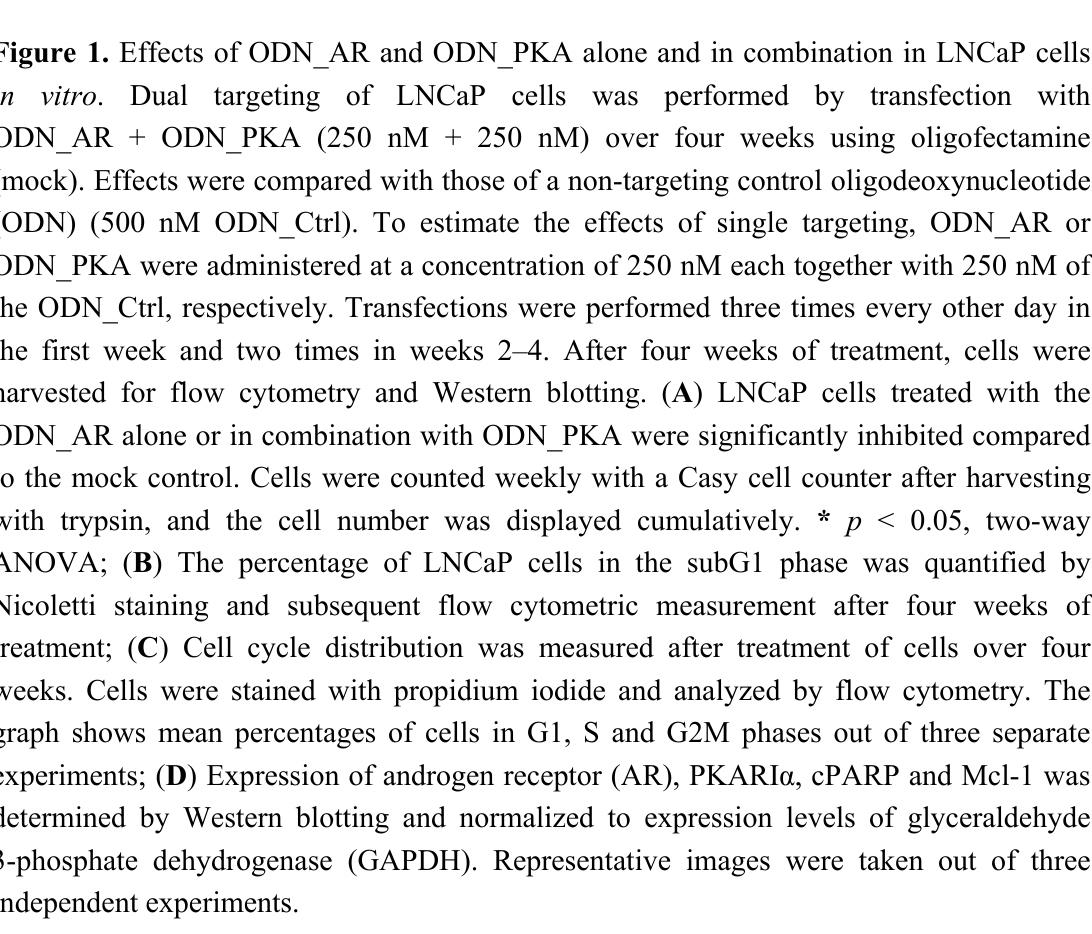
Figure 1. Effects of ODN_AR and ODN_PKA alone and in combination in LNCaP cells in vitro . Dual targeting of LNCaP cells was performed by transfection with ODN_AR + ODN_PKA (250 nM + 250 nM) over four weeks using oligofectamine (mock). Effects were compared with those of a non-targeting control